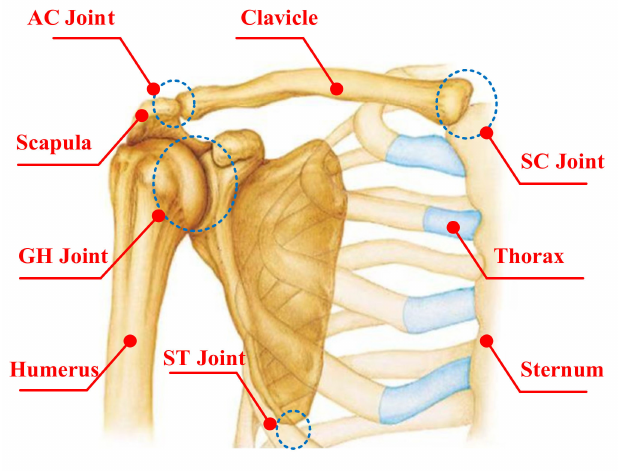
Figure 1. Anatomy of the shoulder